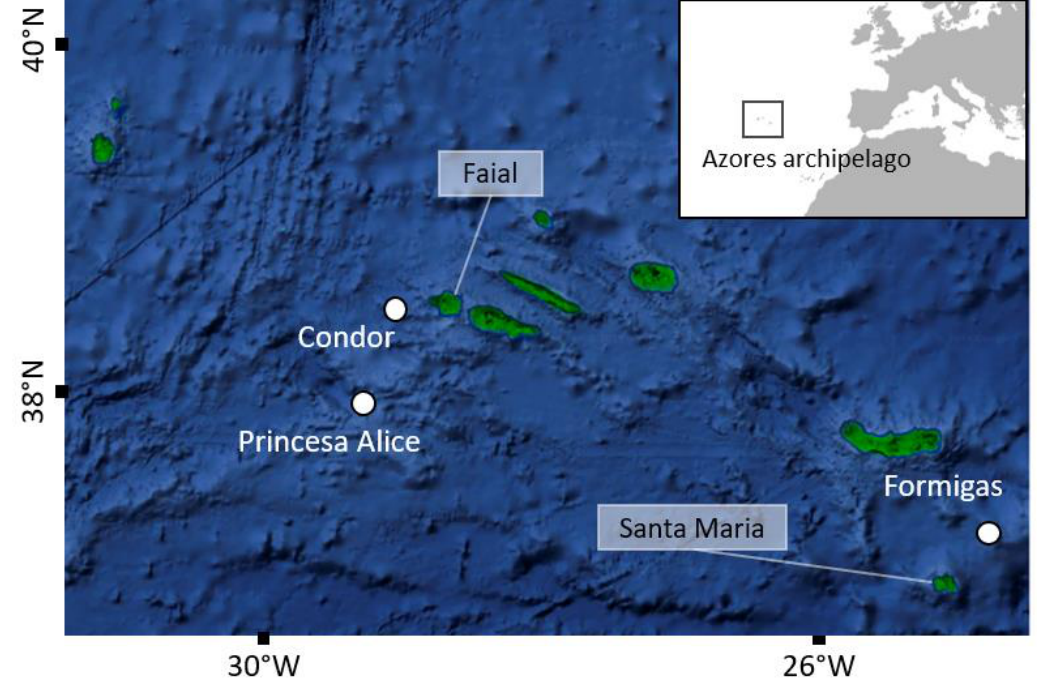
Figure 1. Location of the deployment of the Ecological Acoustic Recorders (EARs) in three seamounts of the Azorean archipelago (white dots).